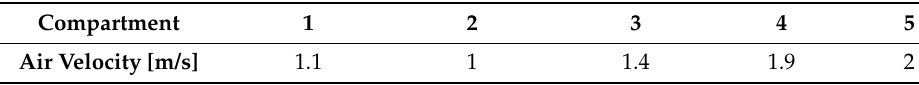
Table 5. Superficial air velocity in each compartment.